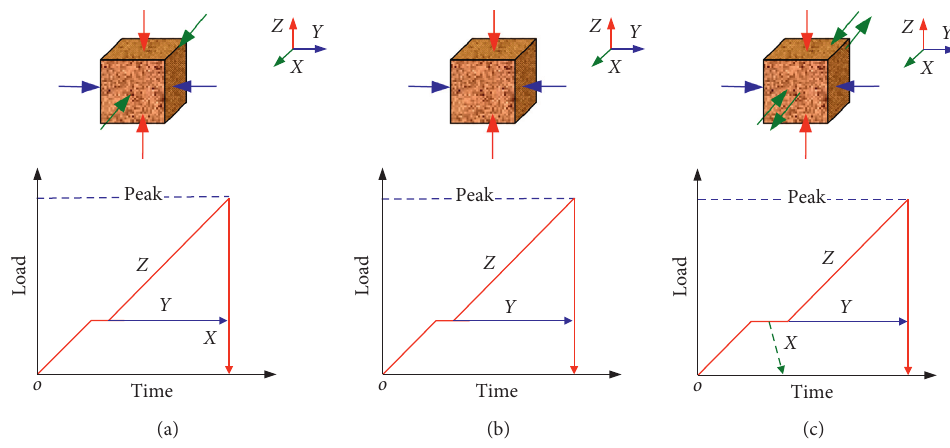
Figure 3: Test loading path: (a) TCT, (b) BCT, and (c) TLU (or